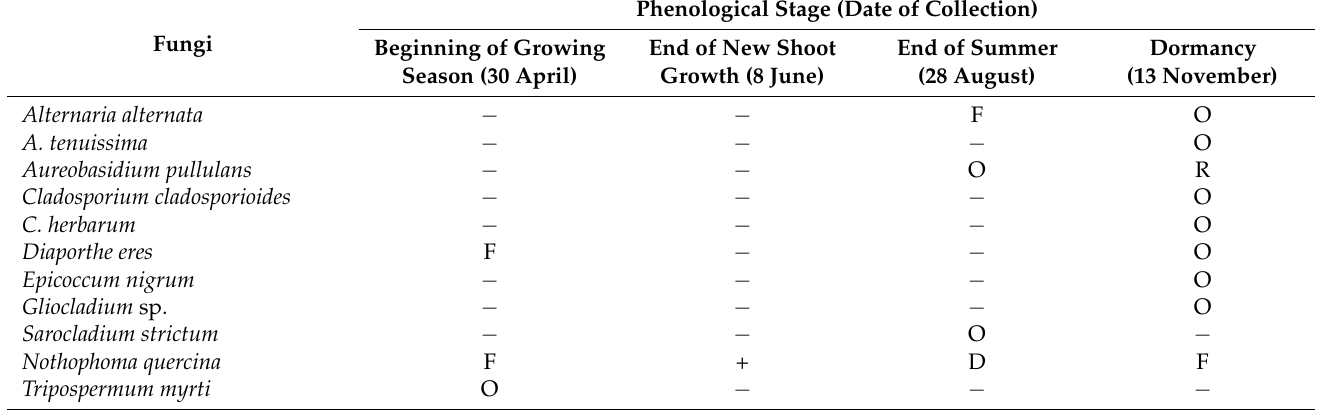
Table 5. Species composition and a frequency of occurrence of fungi isolated from the Manchurian apricot shoots during the vegetation period of